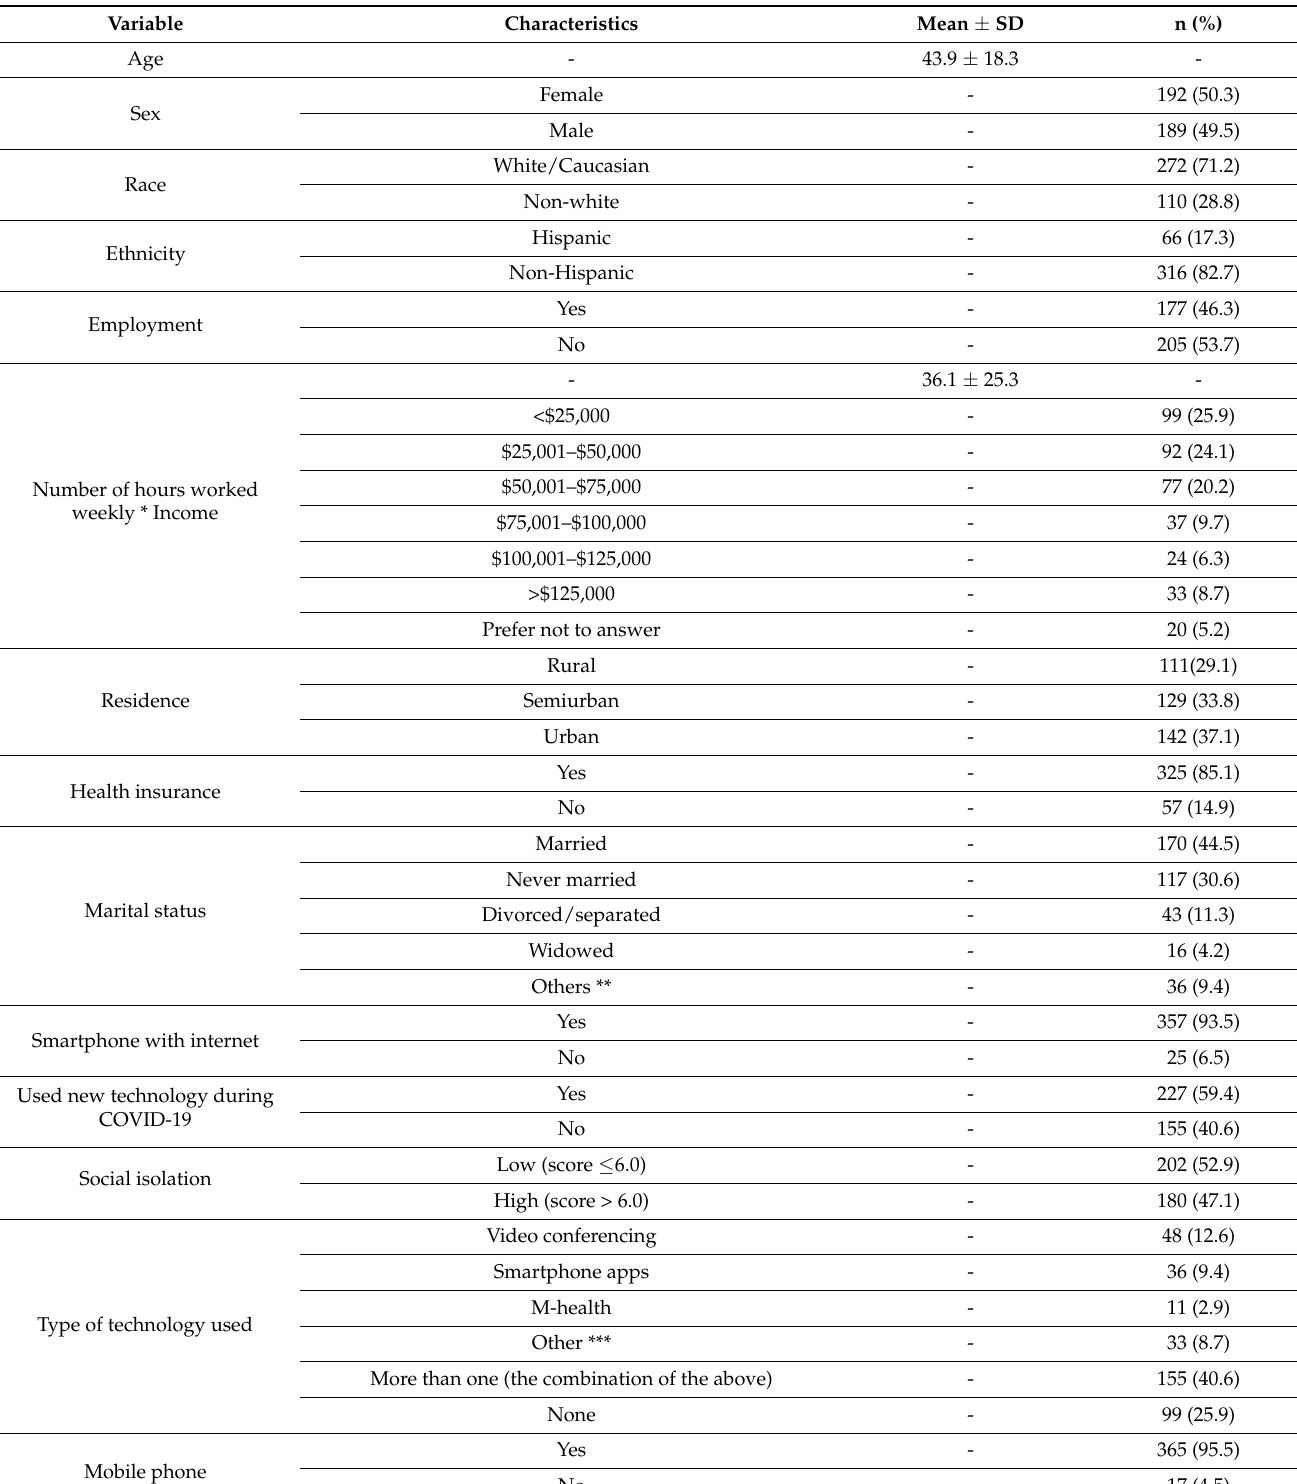
Table 1. Descriptive statistics of the study population ( n =